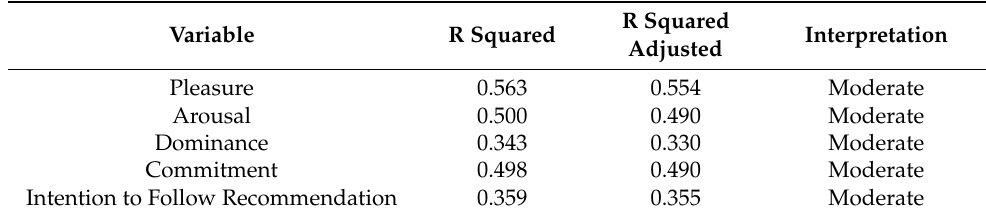
Table 7. Coefficient of determination test results (R squared).